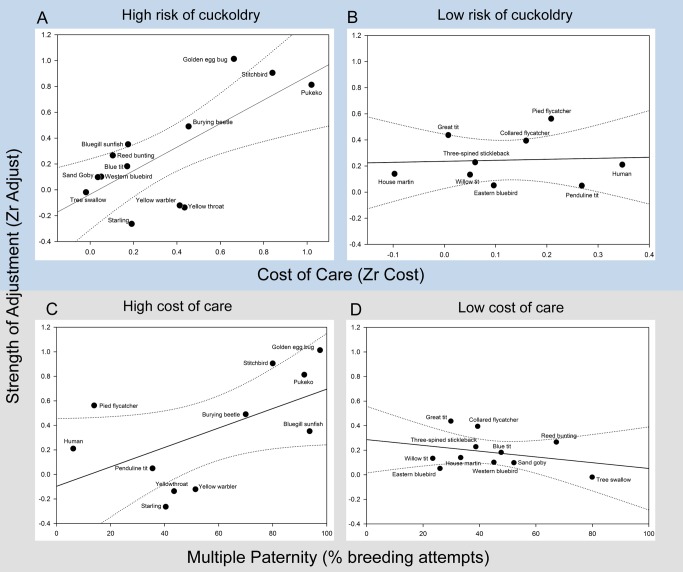
The strength of adjustment of paternal care is determined by factors affecting male reproductive success.The adjustment of paternal care is determined by an interaction between the risk of cuckoldry and the costs of care to future reproductive success. ZrAdjust was positively related to ZrCost when multiple paternity was high ((B) multiple paternity is above the median), but not when multiple paternity was low ((A) multiple paternity less than or equal to the median). Similarly when opportunity costs to males of caring were high ((D) ZrCost greater than the median) ZrAdjust increased with rates of multiple paternity, which was not the case when costs to males were low ((C) ZrCost less than the median). Regression lines are presented with 95% CIs. ZrCost and multiple paternity were analysed as continuous variables and have only been dichotomized for graphical purposes.